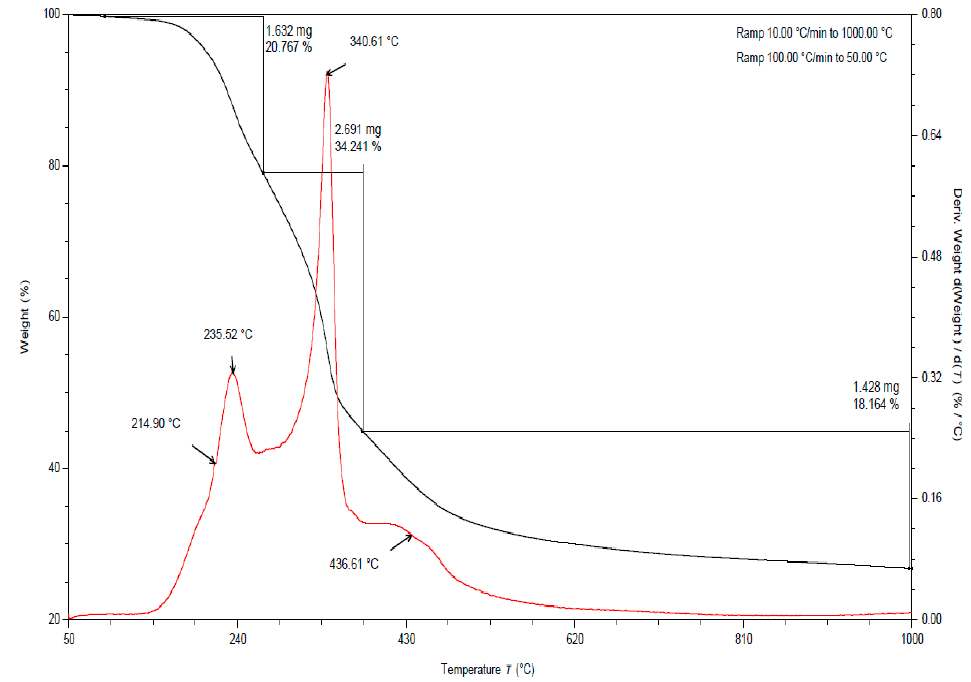
Figure 2. TGA curve for apple pomace dried to dry weight. Analysis in a nitrogen atmosphere (black line is a plot of mass loss versus temperature, red line is the first derivative).